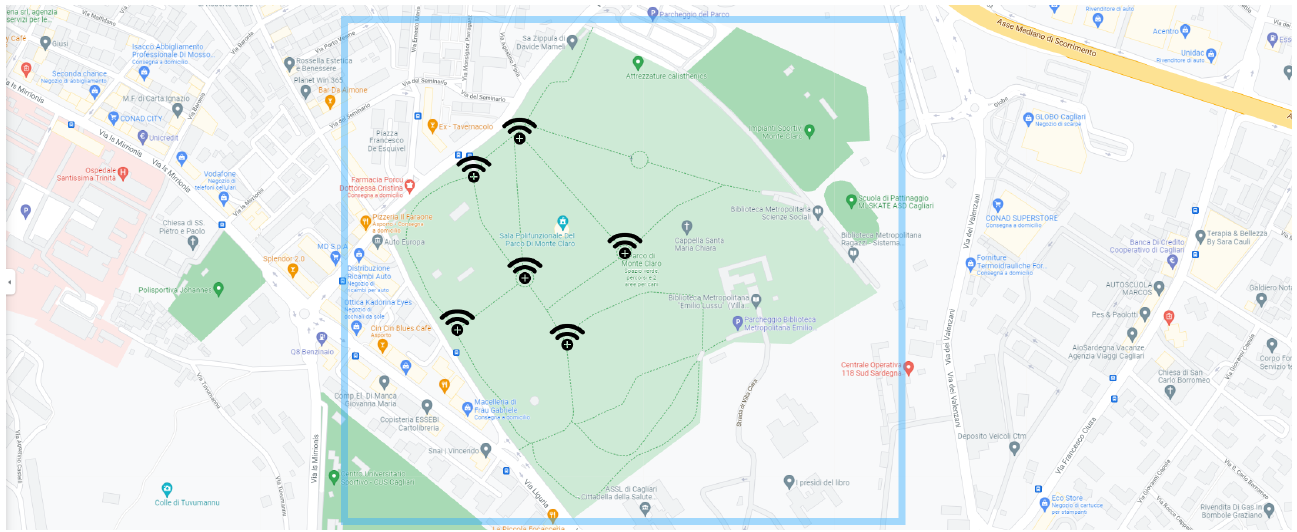
Figure 11. Map of the experiment venue, with the position of each tracker